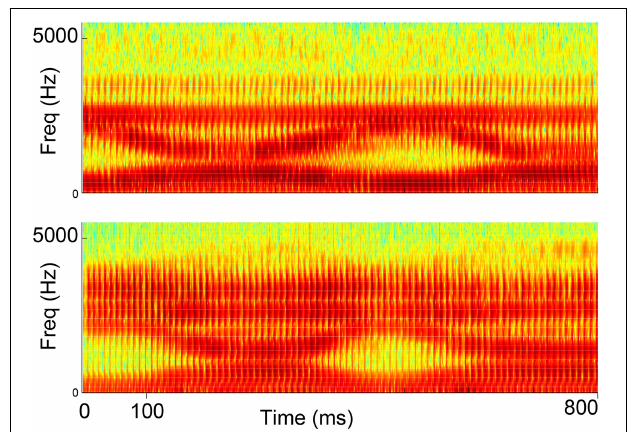
FIGURE 6 | Spectrograms of synthesized speech generated from myocontrol (top) and natural human speech (bottom) for the vowel sequence “ee-ah-ee-ah.”